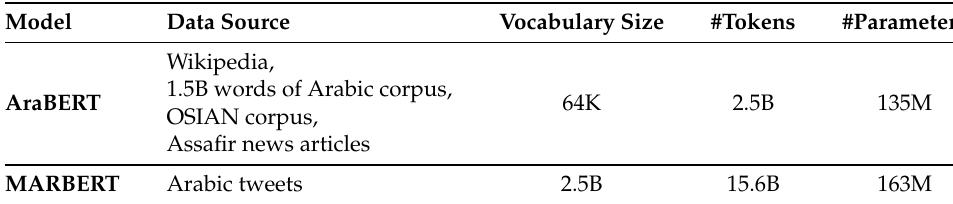
Table 2. Comparison between AraBERT and MARBERT transformers.